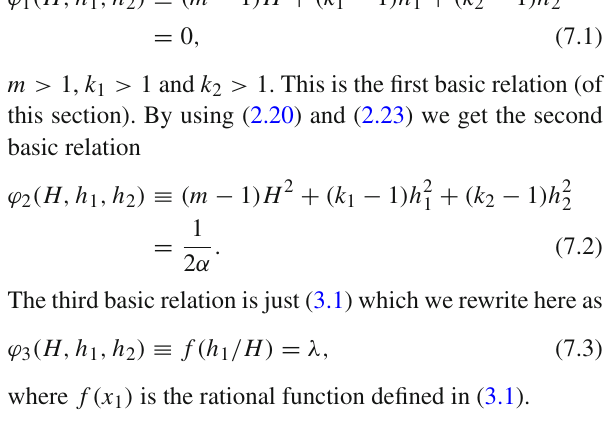
dimensional manifold, which is obtained from the ellipse E by deleting 10 points. It is a disjoint union of ten arcs. Any of these arcs is parametrized by the pair (λ, s ) , where s is the number of the arc and λ is local coordinate given by